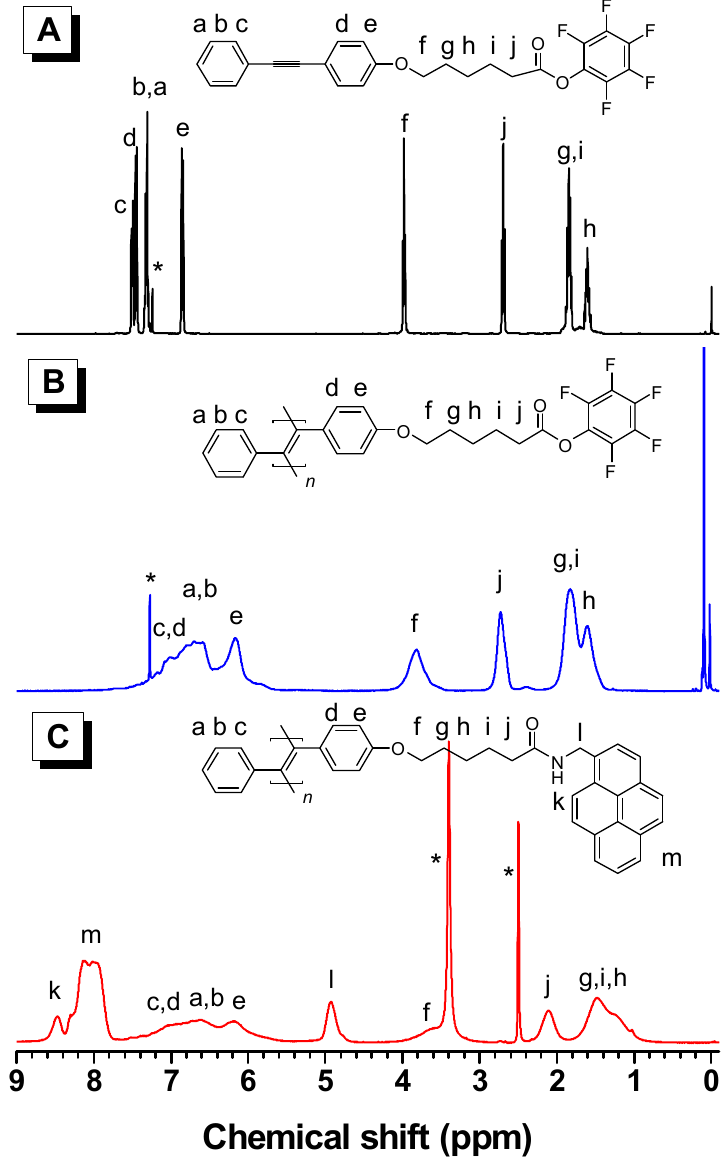
Figure 3. 1 H NMR spectra of ( A ) monomer 1 (in chloroform- d ), ( B ) precursor P 0 bearing activated ester groups (in chloroform- d ), and ( C ) pyrene-functionalized poly(diphenylacetylene) derivative P 1 (in DMSO- d 6). The solvent and water peaks are marked with asterisks.